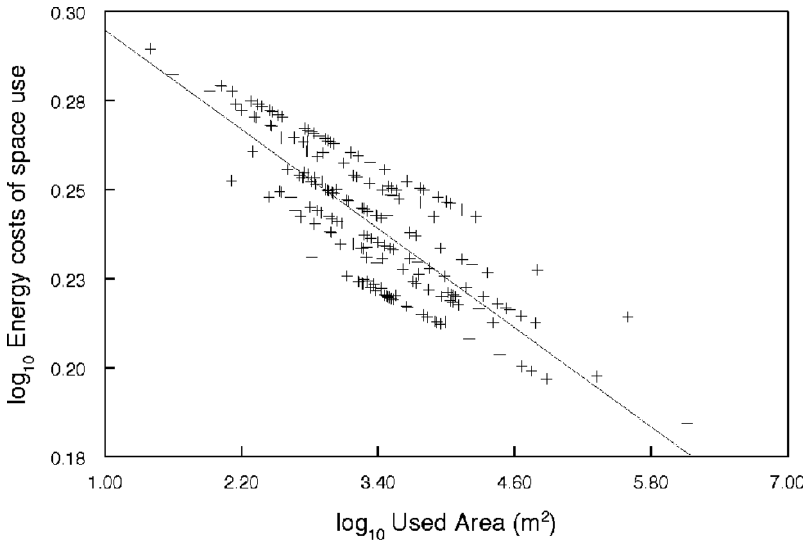
Figure 1. The relationship between energy costs of space use and the size of used area. Predicted values are from log 10 transformed data.